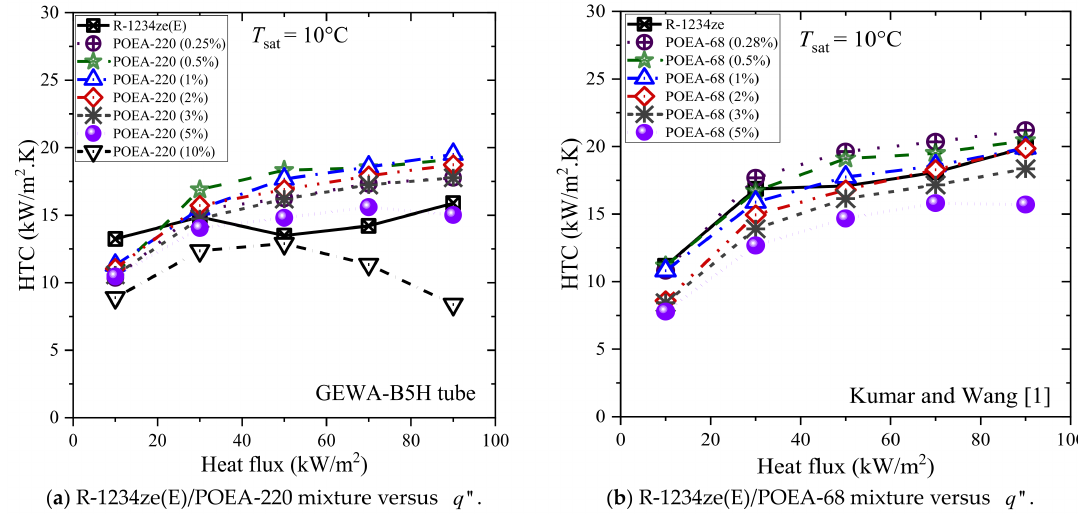
Figure 5. HTC versus q (cid:48)(cid:48) . ( a ) R-1234ze(E)/POEA-220 mixture ( b ) R-1234ze(E)/POEA-68 mixture at 10 ◦ C.